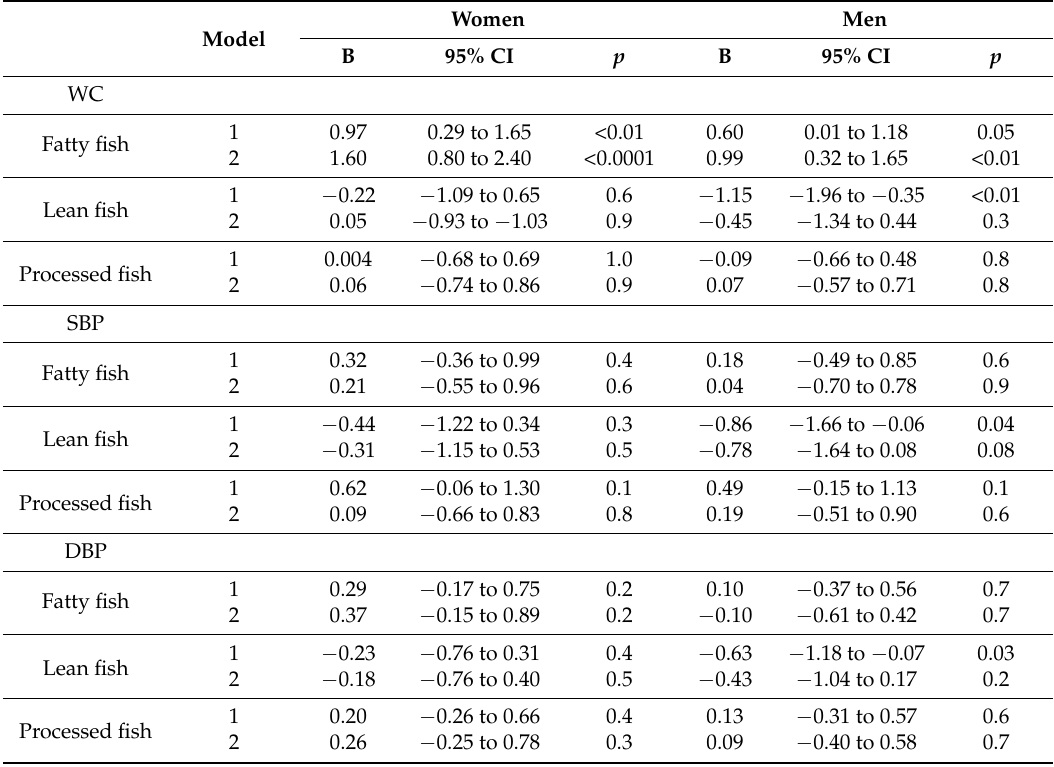
Table 6. Estimated change in waist circumference and blood pressure, by consumption of fish.